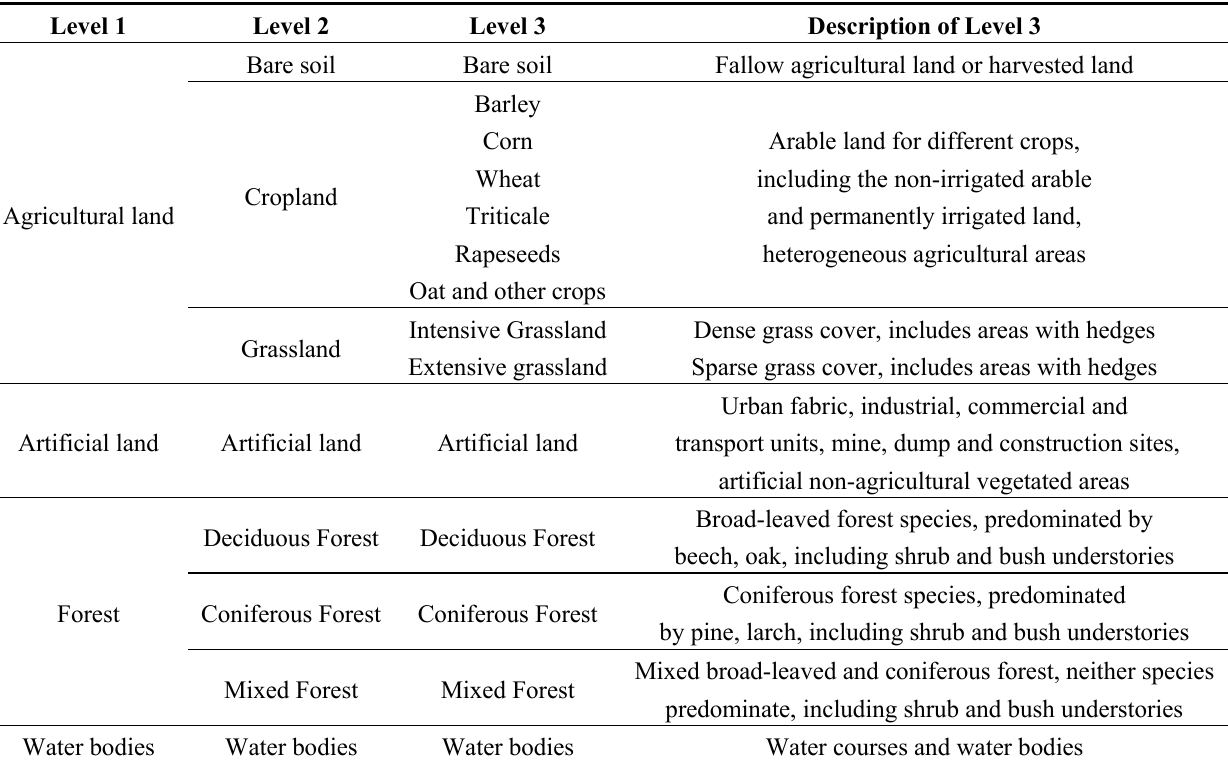
Table 3. Land use and land cover categories for the three-level classification scheme including the 4 classes of Level 1,7 classes of Level 2, 14 classes of Level 3 and the brief description of the Level 3